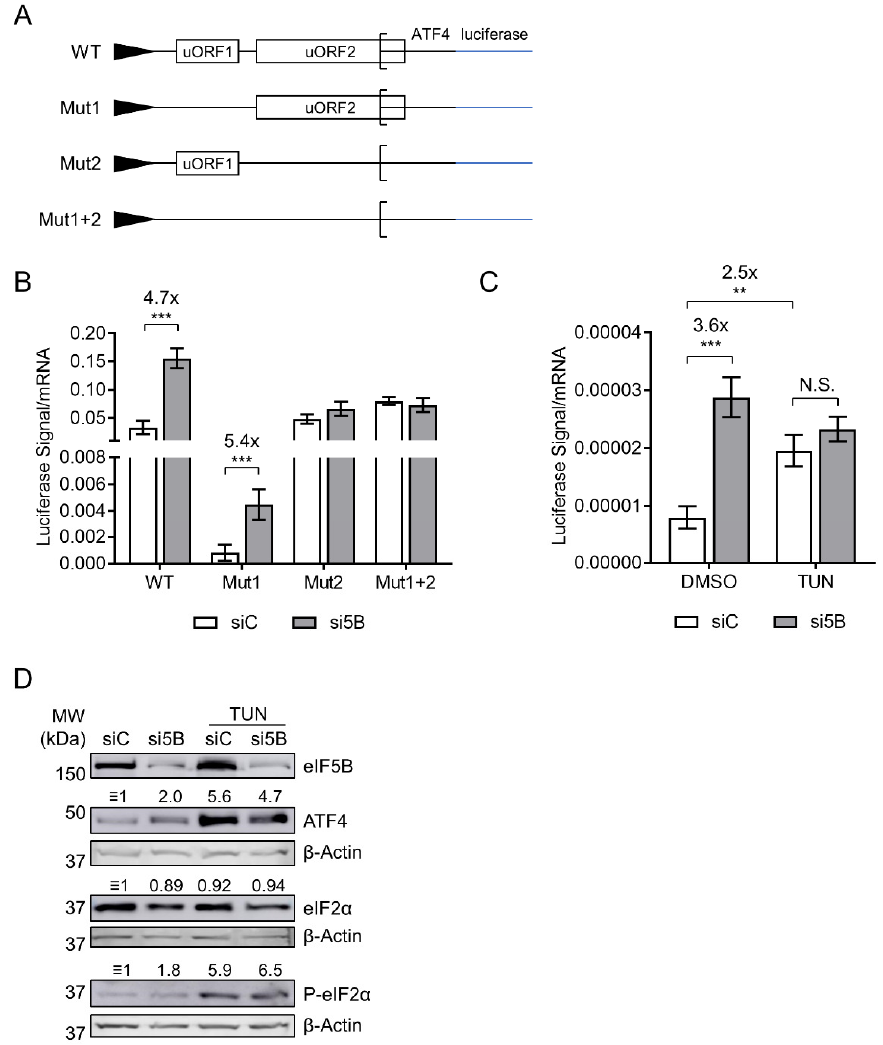
Figure 3. eIF5B represses ATF4 translation by a uORF-dependent mechanism. ( A ) Schematic representation of the ATF4-firefly luciferase reporter fusions used in this study, all transcribed from a minimal TK promoter. Note that Mut1 and Mut2 possess a start codon mutation (ATG to AGG) that inactivates the regulatory functions of uORF1 and uORF2, respectively. Mut1+2 possesses both mutations. ( B ) Control or eIF5B-depleted HEK293T cells were transfected with the above-mentioned plasmids (48 h post siRNA transfection). After another 48 h, the luminescence from firefly luciferase was measured and normalized to the steady-state levels of firefly luciferase mRNA (measured by RT-qPCR). ( C ) Luciferase levels were measured as in panel ( B ), except that the cells were treated with 5 µ g/mL tunicamycin (TUN) for the last 6 h of the incubation prior to harvesting. Data are expressed as mean ± SEM for 3 independent replicates. ** p < 0.01; *** p < 0.001. ( D ) Immunoblots probing for eIF5B, ATF4, eIF2 α , P-eIF2 α , or β -Actin (internal control). Numbers above the blots represent their quantitation relative to β